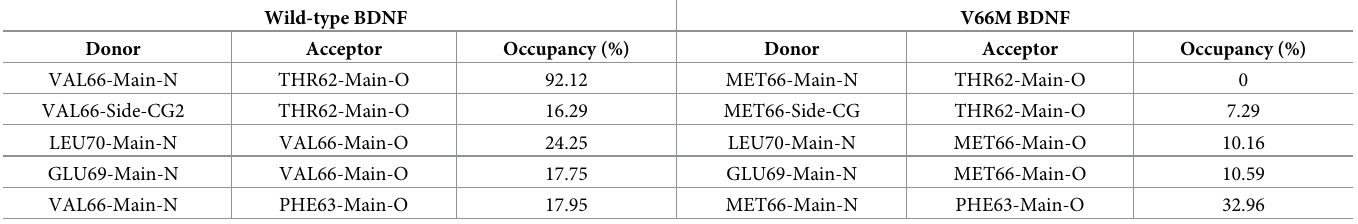
Table 2. Hydrogen bond occupancy of the residue 66 during the MD simulations of BDNF wild-type and its V66M variant. Wild-type